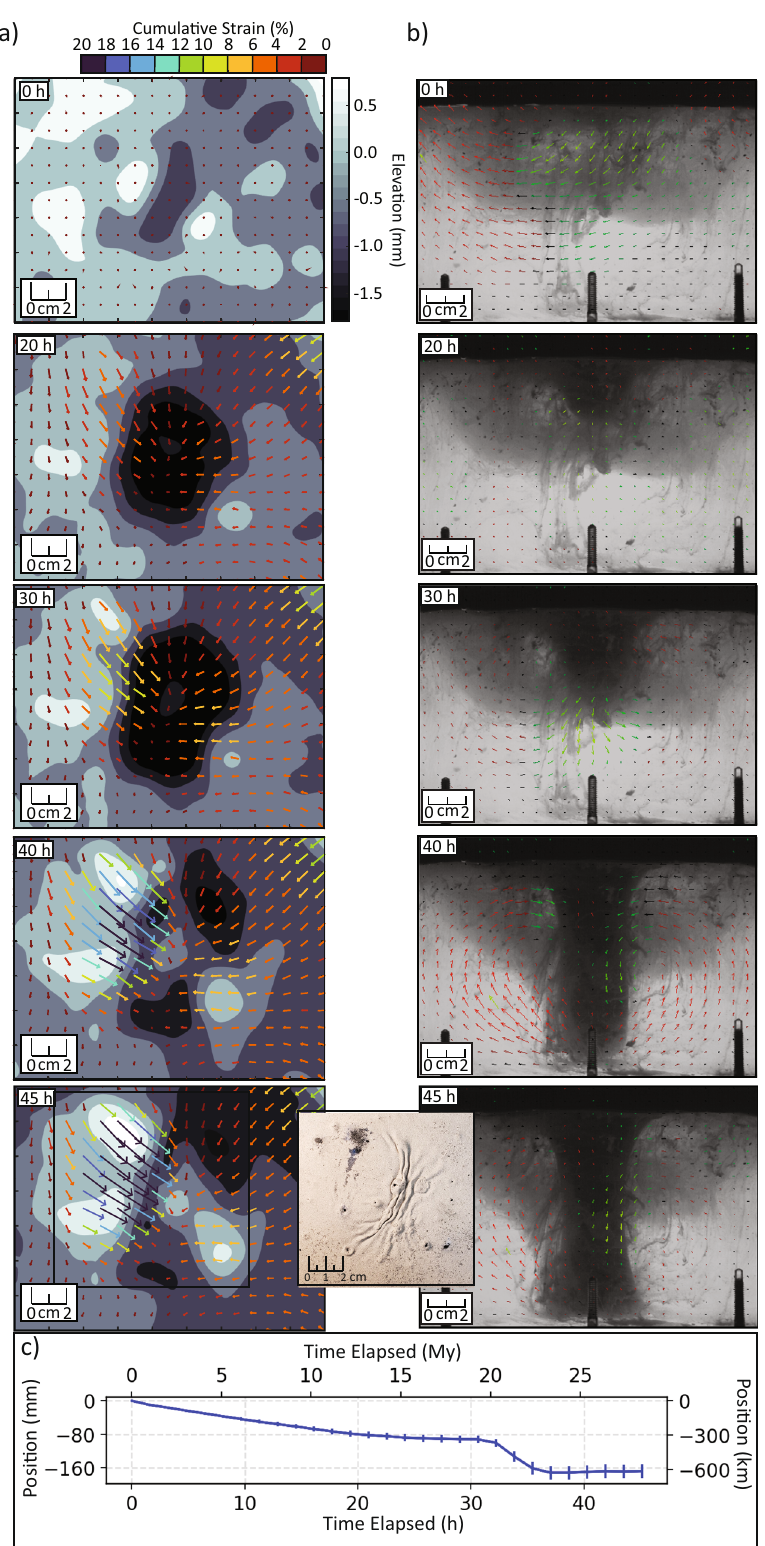
Fig. 4 Evolution of EXP-3. a Plan view evolution of topography over 40 h with cumulative surface strain. Full extension of the lithosphere was visible in the crust at 45 h (top left of photograph). b Below surface (sideview) evolution of the drip. The cloud surrounding the drip is visible discoloration of the (polydimethylsiloxane) PDMS from the clay in the mantle lithosphere. Green vectors show downwward motion of drip while red vectors illustrate out and upward movement of the PDMS (mantle). c Progression of the drip beneath the base of the mantle lithosphere. Drip progression temporarily ceases at ~25 h before sinking again at ~32 h. The drip touched the bottom of the box at ~37